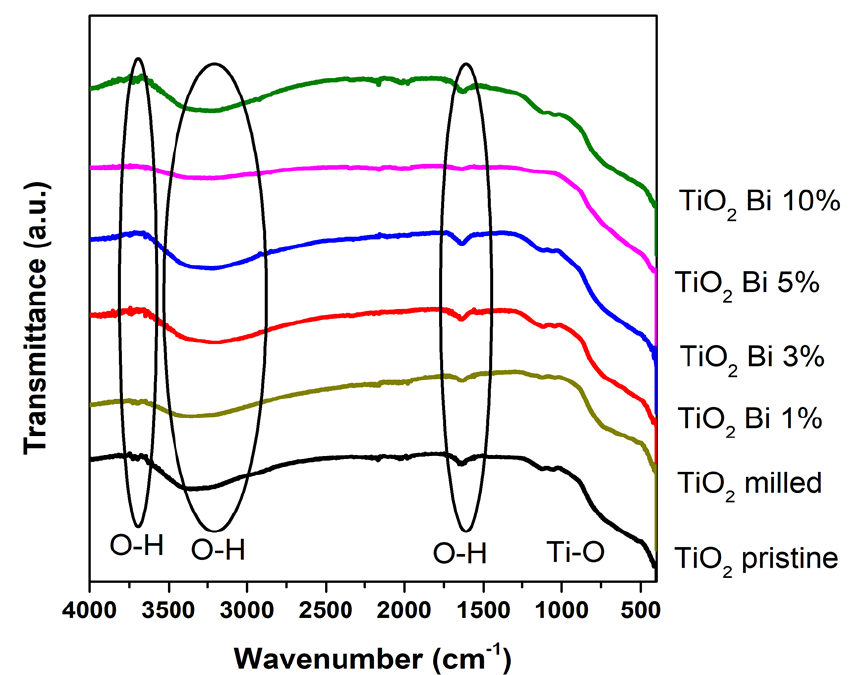
Figure 1. FTIR ‐ ATR spectra of the pristine TiO 2 , milled TiO 2 , and Bi ‐ doped TiO 2